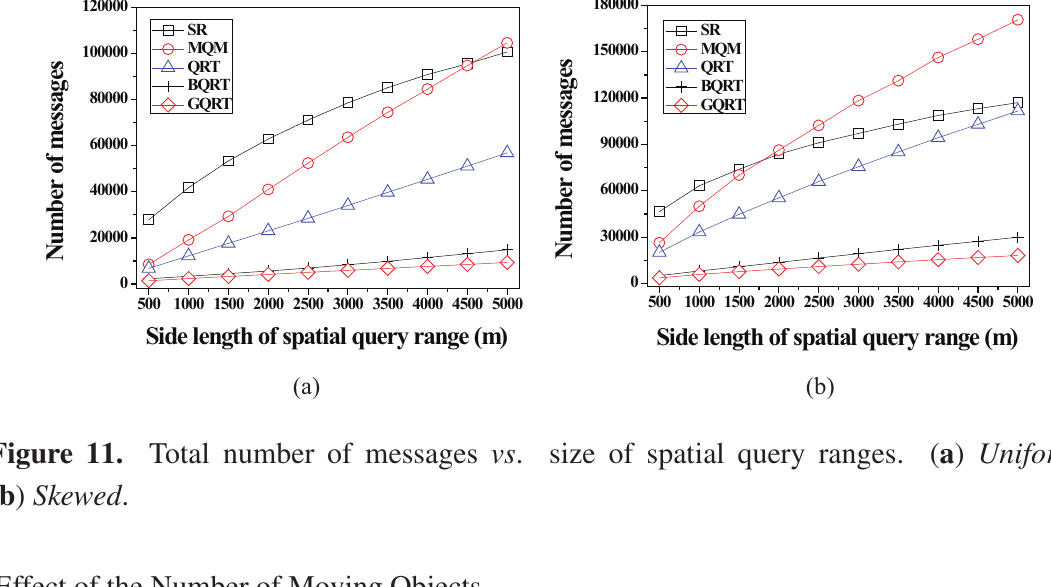
Figure 11. Total number of messages vs . size of spatial query ranges. ( a ) Uniform ; ( b ) Skewed .